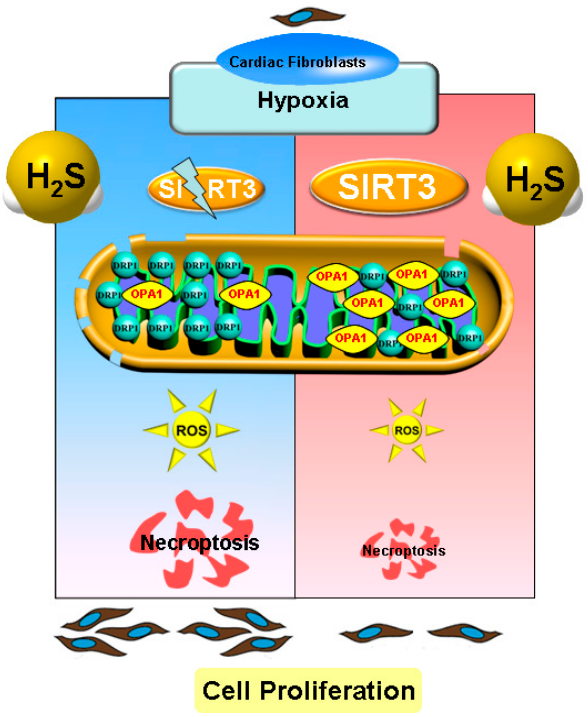
Figure 10. Illustration of the mechanism by which H 2 S suppressed hypoxia-induced cardiac fibroblasts proliferation. Exogenous H 2 S supplementation restored the balance between the DRP1 and OPA1 protein expression, reduced oxidative stress, attenuated necropoptosis, and inhibited cell proliferation in cardiac fibroblasts with hypoxia. H 2 S also enhanced SIRT3 expression in cardiac fibroblasts with hypoxia. Moreover, after SIRT3 siRNA transfection, the inhibitory effects of H 2 S on oxidative stress, necroptosis, and cardiac fibroblasts proliferation were all weakened. This suggests that necroptosis inhibition by H 2 S suppressed hypoxia-induced cardiac fibroblast proliferation via SIRT3.